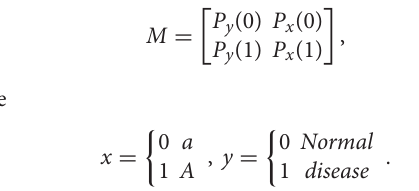
Algorithm 1 in Kocaoglu et al. (2016) assumed that the number of states of the variables X and Y is equal, which prevents application of Algorithm 1 to causal genetic analysis for genotype